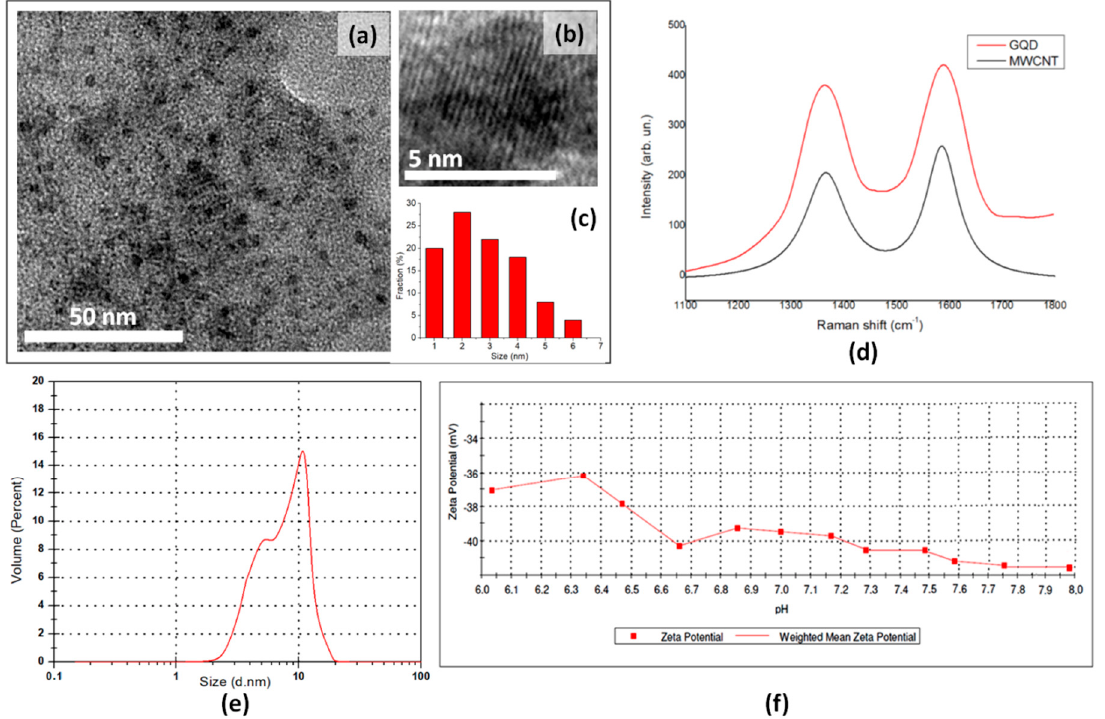
Figure 2. ( a ) Representative TEM image of the as-prepared GQD; ( b ) high-resolution TEM image showing the crystal structure of an individual GQD;( c ) size distribution of GQD derived from TEM images; ( d ) Raman spectra of GQD and MWCNT; ( e ) volume-weighted size distribution of GQD dispersions in deionized water; ( f ) isoelectric titration graph of the GQD sample in the pH range of 6–8 (evaluated as dependence of zeta potential on the pH of the medium for aqueous solutions of GQD).